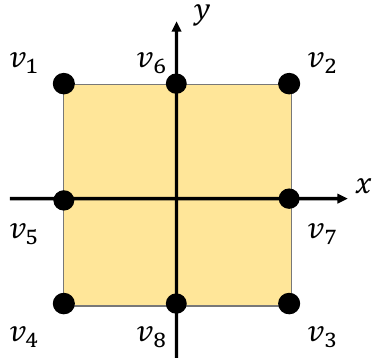
Figure 4. Loci of electrodes on the